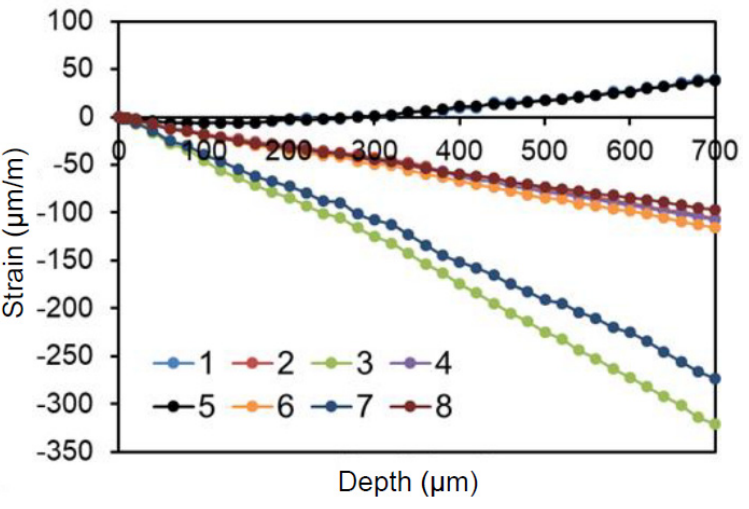
Figure 12. Determination of strains for GFRP using the customized eight grid strain gauge.